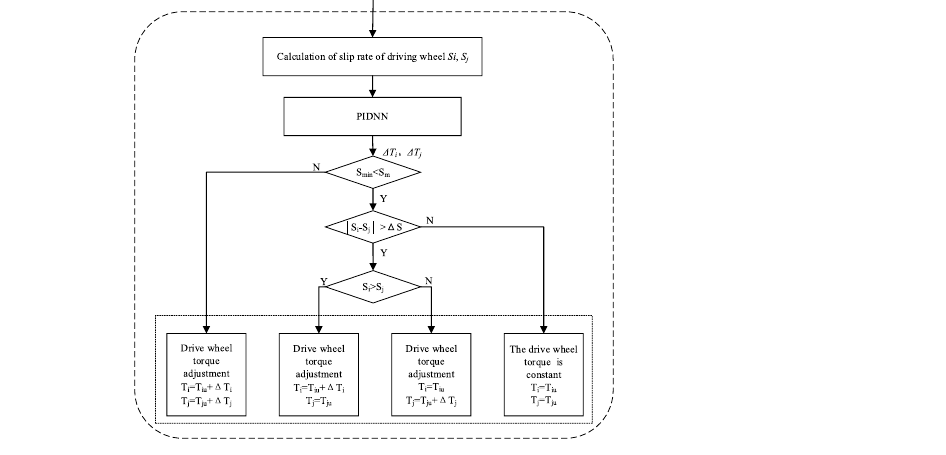
Figure 4. Structure of the slip rate controller.